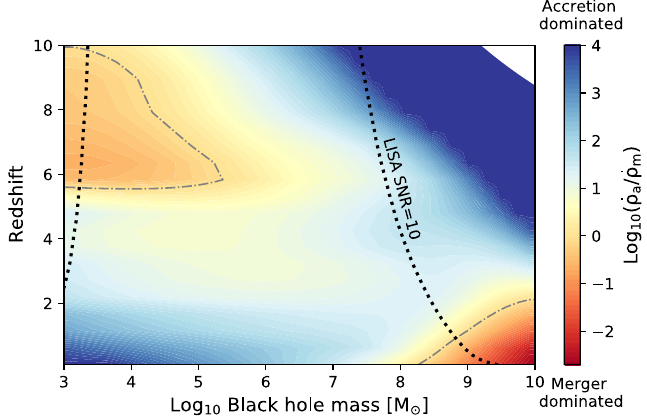
Fig. 23 Predictions on the relative importance of MBH growth by gas accretion (blue shades) and mergers (red shades). _ q a and _ q m are the predicted mass growth rates by gas accretion and mergers, respectively. The contour where _ q a ¼ _ q m is represented with a dash-dotted line. The region corresponding to a LISA signal- to-noise ratio (cid:7) 10 for MBHBs with mass ratio 0.2 is delimited within the two thick, dotted lines. The whited-out area on the top right corner indicates the region of the parameter space where no MBHs should be present (adapted from Pacucci and Loeb